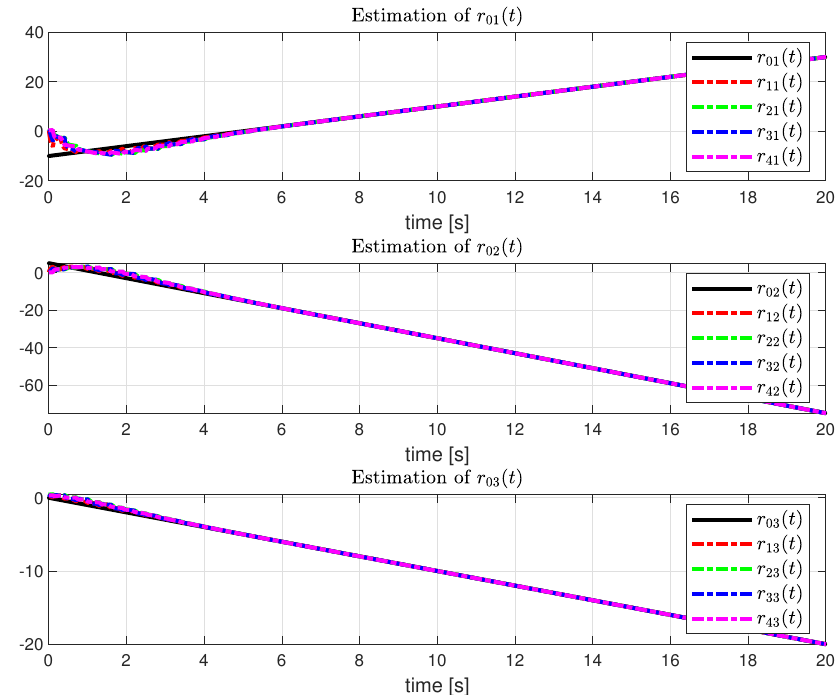
Figure 4. Performance of the distributed